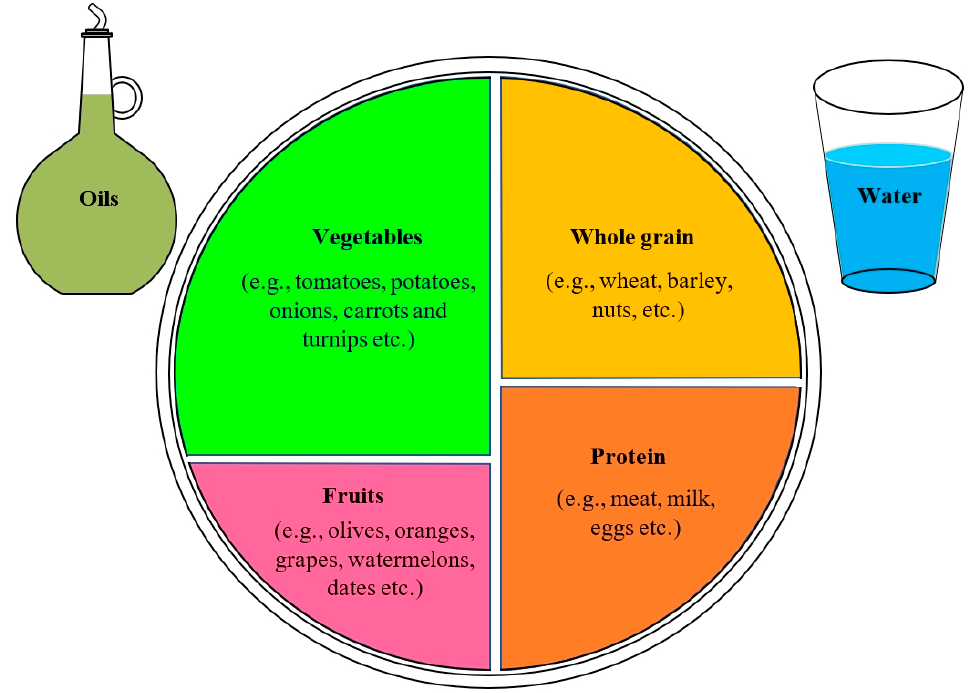
Figure 4. Healthy Eating Plate based on typical Libyan produce (based on [33]).